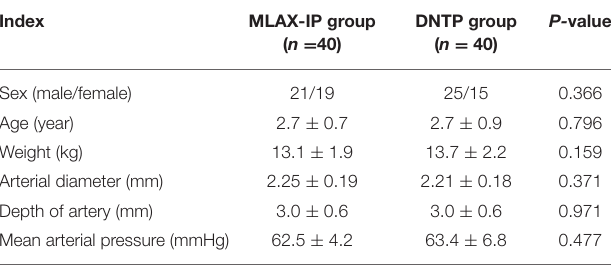
TABLE 1 | The characteristics of infants.